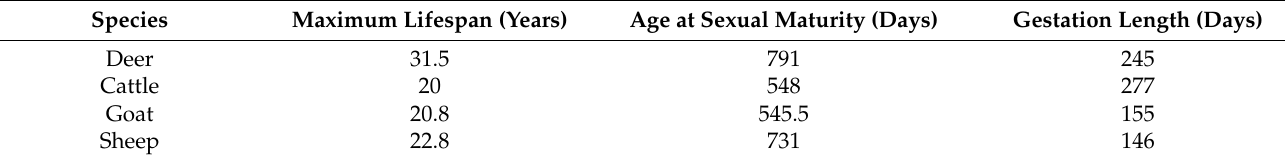
Table 1. Maximum life span and average life-history periods for deer, cattle, goat and sheep sourced from the AnAge database (http://genomics.senescence.info/help.html#anage, accessed on 24 June